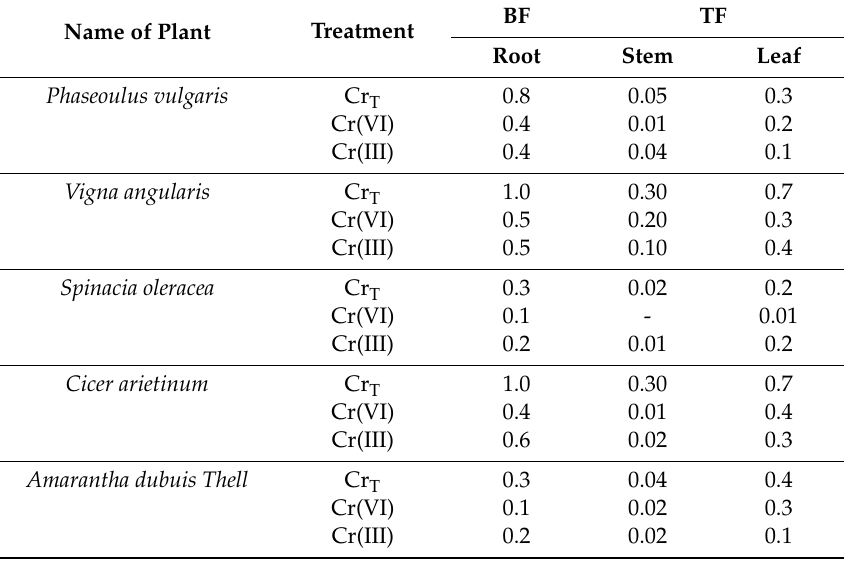
Table 4. The Bioaccumulation Factor (BF) and Translocation Factor (TF) of total chromium (Ch T ), Cr(VI) and Cr(III) in the di ff erent parts of vegetable plants at the harvesting stage found between Cr oxidation states and plant species ( p <